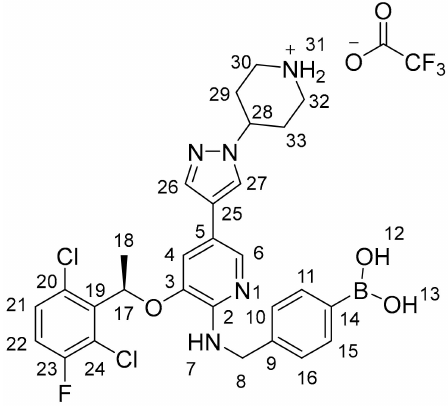
Figure 8. Structure and NMR numbering of prodrug B